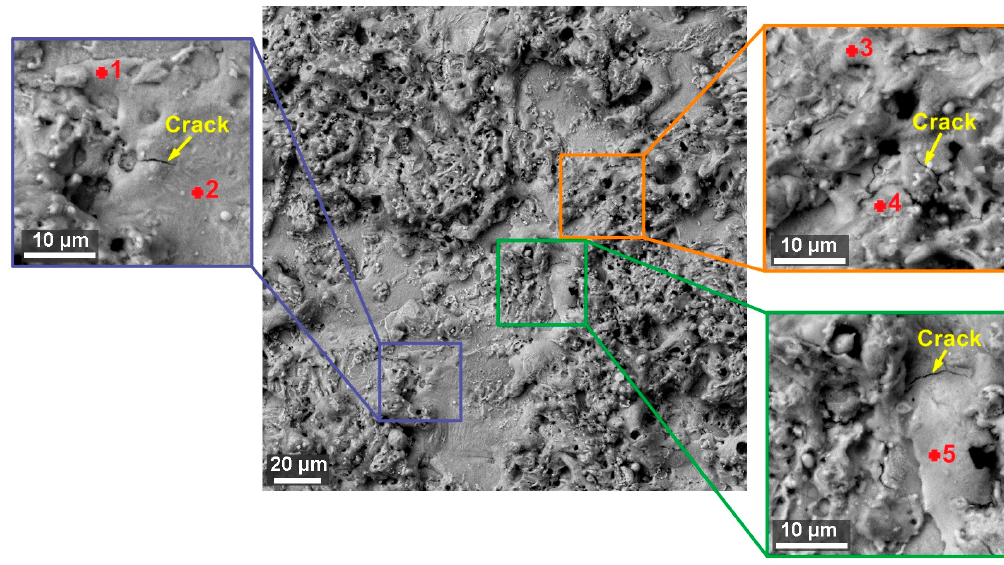
Figure 7. Surface morphology of Sample 20 (machined by setting machine parameters: U = 70 V, T on = 6 µs, T off = 50 µs, v = 14 m/min, and I = 25 A) made of 1Fe0.2C alloy (SEM/BSE) including details and marking of places where EDX analysis was performed, the results of which are in Table 7. Table 7. Analysis of chemical composition in individual places according to Figure 7 in wt. %. Element